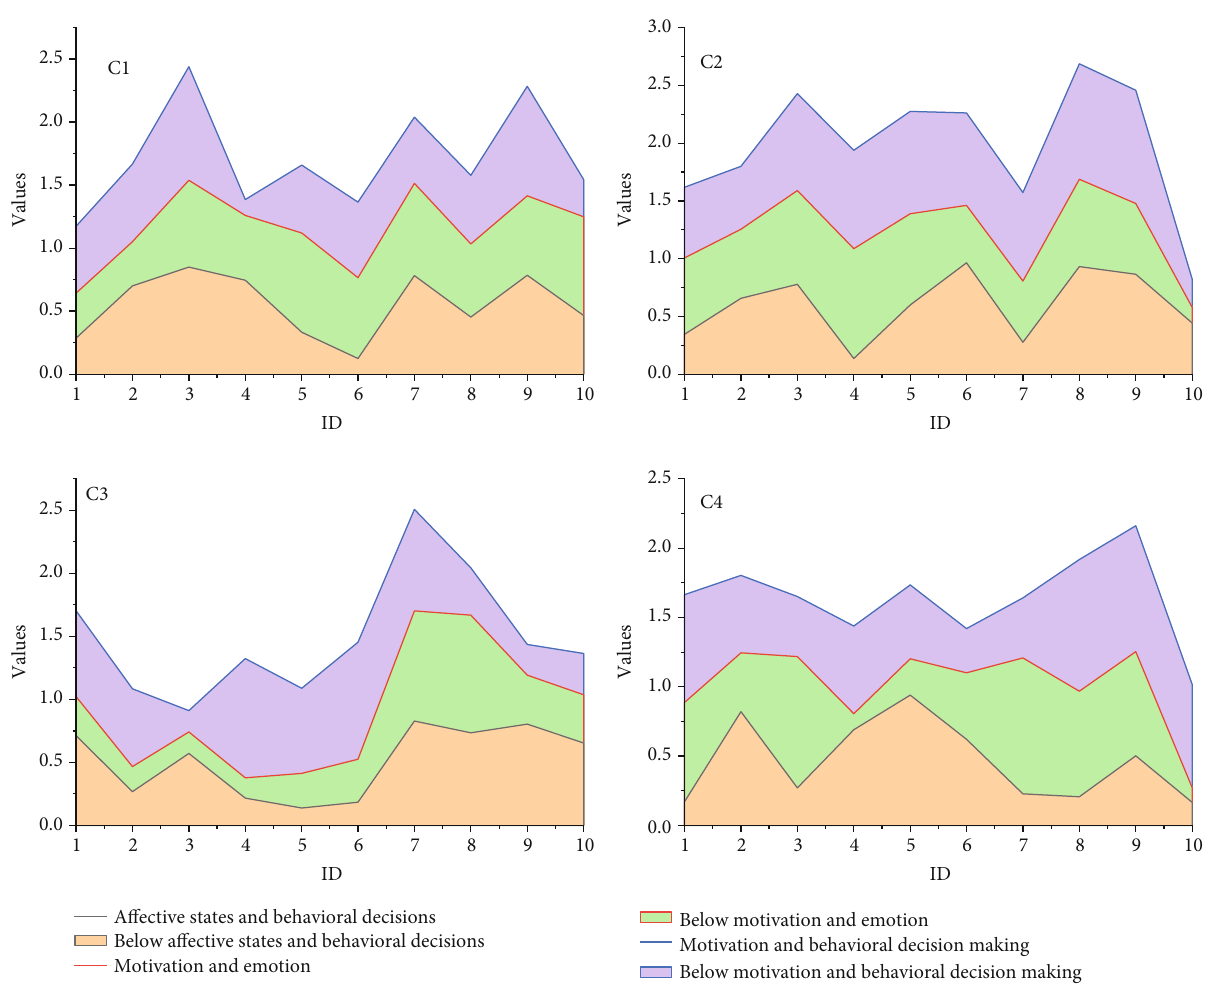
Figure 4: Correlation coe ffi cients for di ff erent con fi